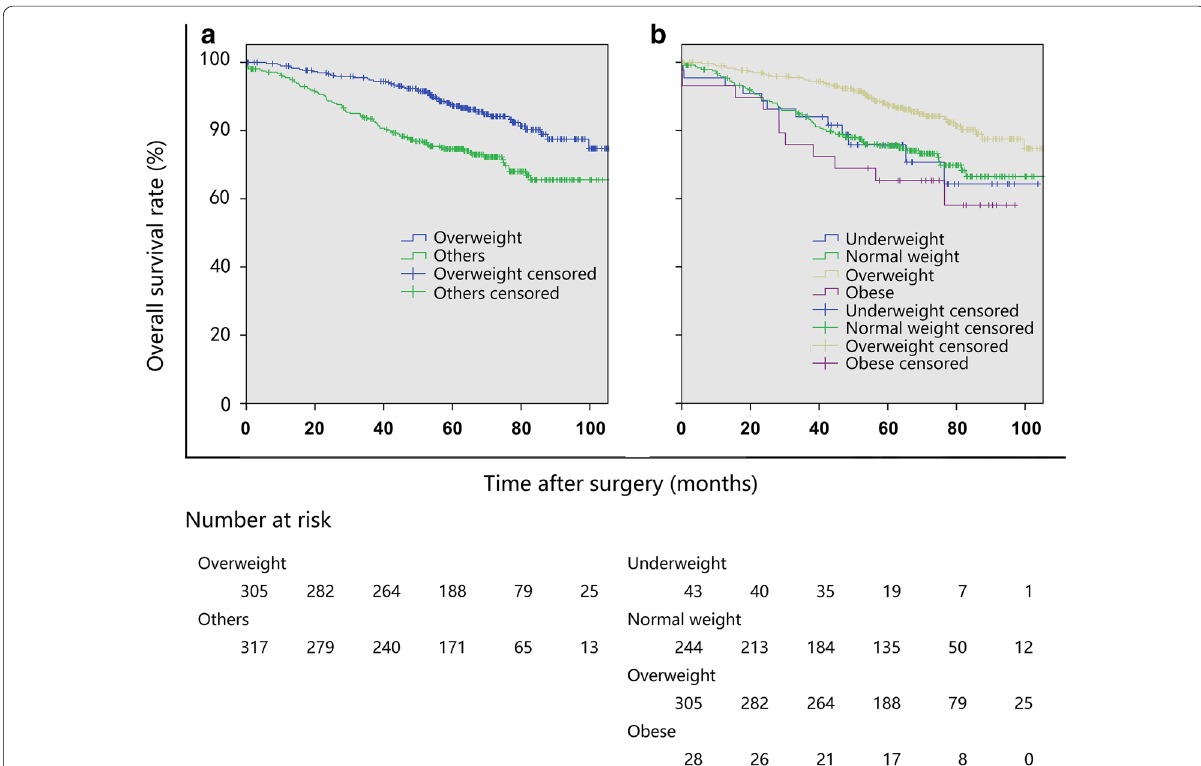
Fig. 1 Kaplan–Meier overall survival (OS) curves of patients with stage I non‑small cell lung cancer (NSCLC) stratified by body mass index (BMI). Underweight BMI < 18.5 kg/m 2 ; normal weight BMI 18.5–22.4 kg/m 2 ; overweight BMI 22.5–28.0 kg/m 2 ; and obese: BMI > 28.0 kg/m 2 . a The OS was longer in the overweight group than in other groups in combination ( P 0.001). b The OS was longer in the overweight group than in the under‑ = weight group ( P 0.012), the normal weight group ( P 0.001), and the obese group ( P = = =